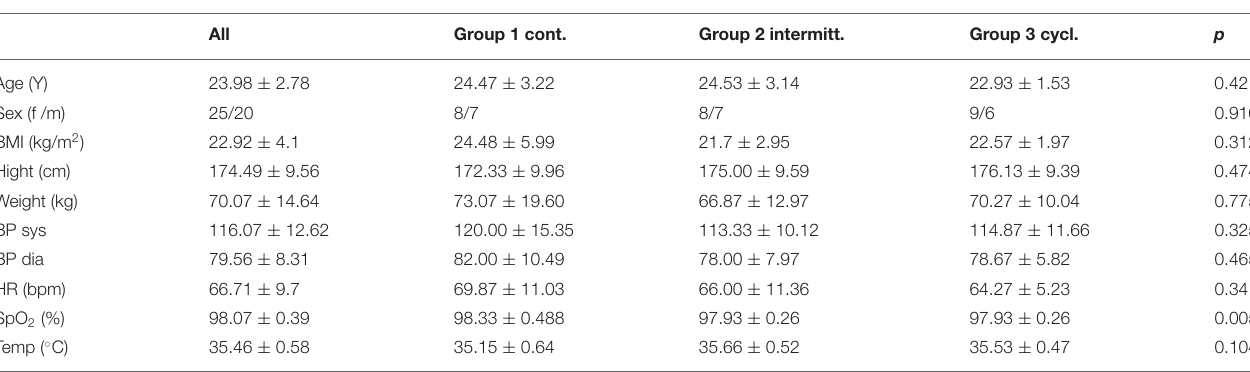
TABLE 1 | General characteristics.